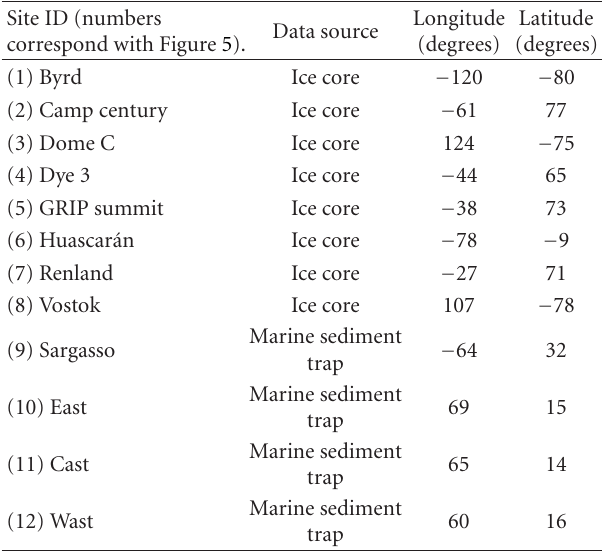
Table 2: Names, data types, and locations of the DIRTMAP deposition data. The numbers on the left hand side of the first column correspond with those in Figure 5. Site ID (numbers correspond with Figure